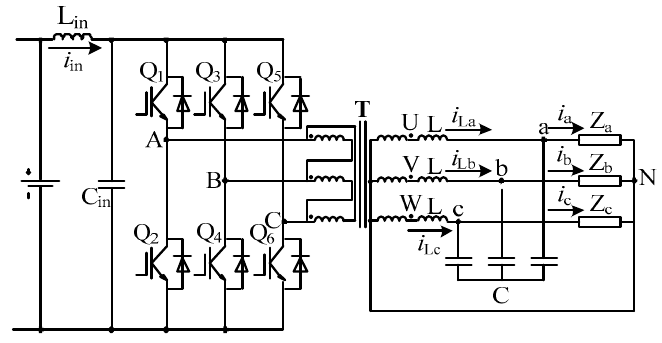
Figure 1. Topology in the current paper.